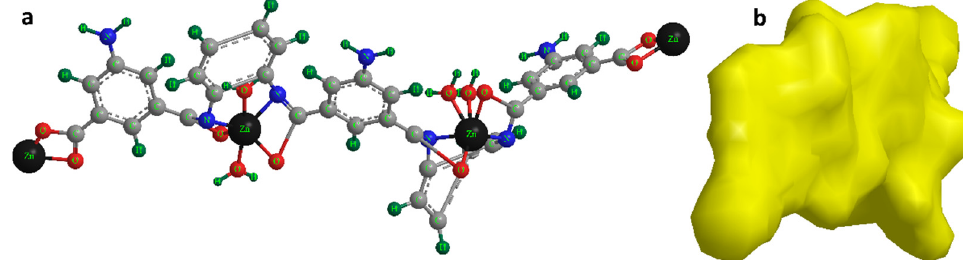
Figure 3. ( a ) The 3D suggested structural for the monomeric unit of the Zn-MOFs-NP; ( b ) Advanced molecular surface illustration.